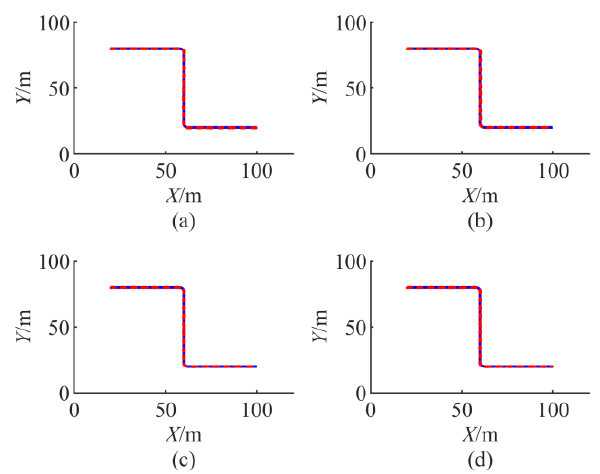
Table 10. The maximum absolute values after weight changing, with the positioning error in ±0.2 m.